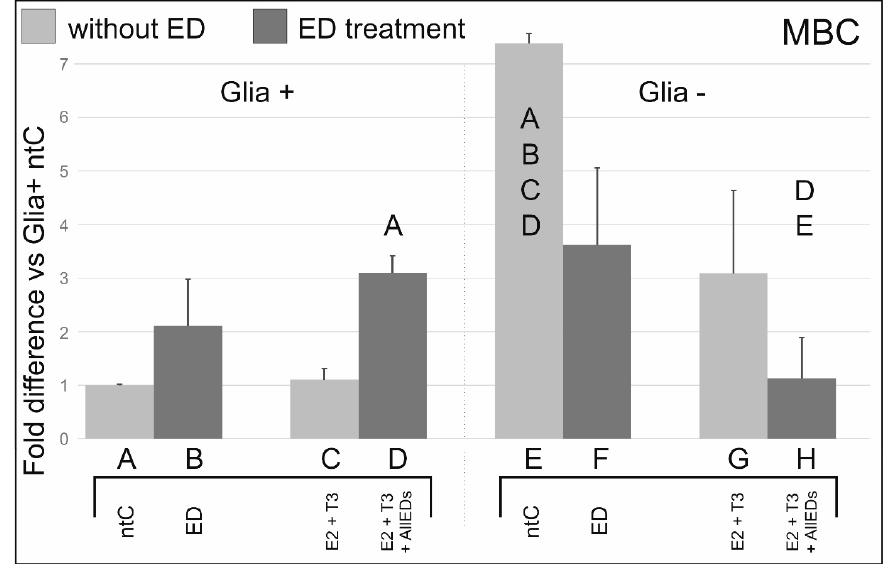
Figure 4. Effects of methylbenzylidene camphor (MBC) with, and without, 17beta-estradiol (E2) and triiodo-thyronine (T3), on ER β mRNA expression. MBC tended to increase ER β mRNA expression in Glia+ cultures. In Glia − , MBC decreased ER β mRNA compared to its respective ntC, and E2 + T3 treated counterparts, although these differences did not reach significance. Letters in and above the columns indicate significant differences ( p ≤ 0.05) from columns below.